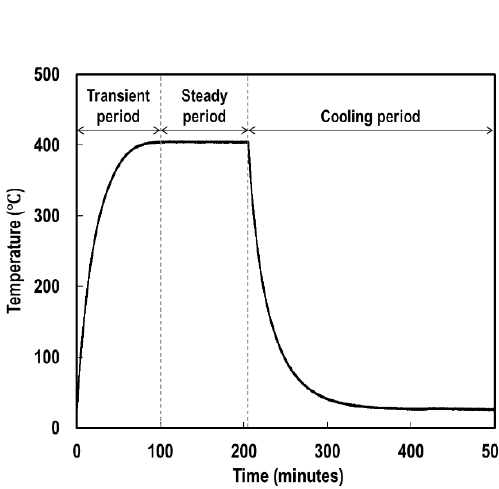
Figure 4. A typical time-temperature relationship of steel blocks tested with the cone calorimeter. Equation (5) includes all the components of the thermal boundaries described in Figure